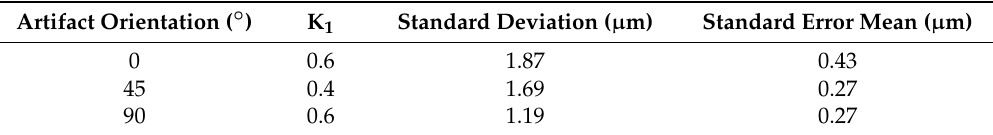
Figure 12. Comparison of experimental roughness and simulated roughness based on Equation (2), for matte artifacts aligned with ( a ) Axis 1, ( b ) Axis 2, and ( c ) Axis 3. Table 6. Theoretical estimation of correction coefficient K 1